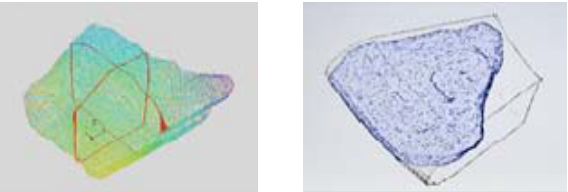
Figure 9: a- Extraction of characteristic profiles; b- Simulation of complete geometry from 3D model of